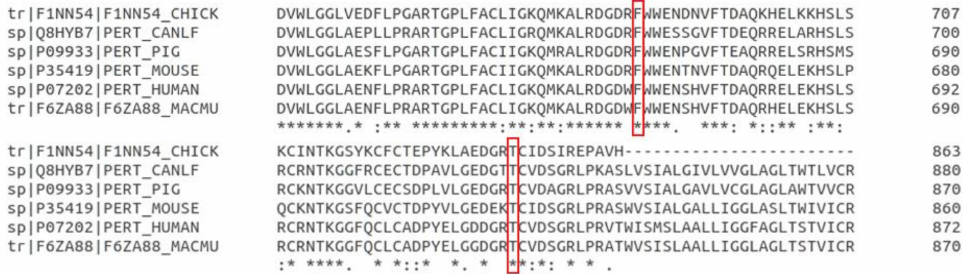
Figure 2. Conservation of the two amino acids of the TPO corresponding to the two deleterious mutations between six species. The two deleterious mutation loci (indicated in red box) are very conserved across